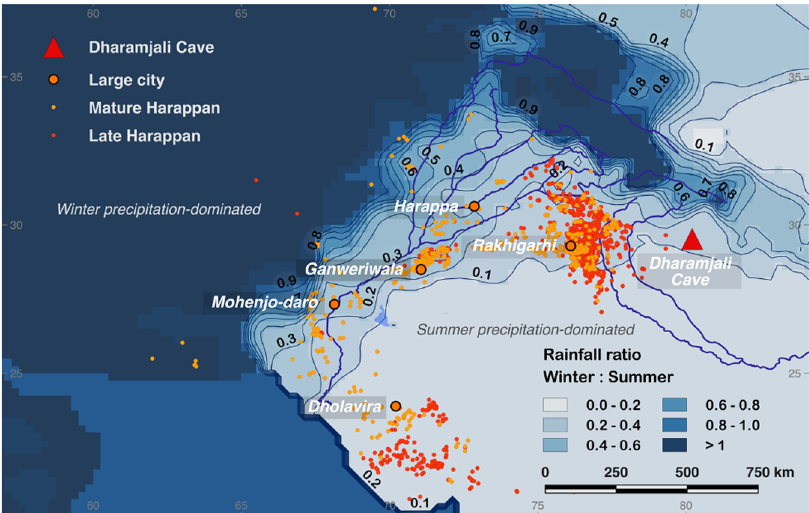
Fig. 1 Local proportion of winter:summer precipitation. Large Indus cities are labeled and shown with the site distribution during the Mature Harappan (c. 4.6 – 3.9 ka BP, orange) and Late Harappan (c. 3.9 – 3.6 ka BP, red) periods. Contour lines represent the ratio of IWM (Nov – Apr) to ISM (May – Oct) precipitation based on the 0.25° GPCC v2018 dataset from 1951 – 2000 rain gauge data 86